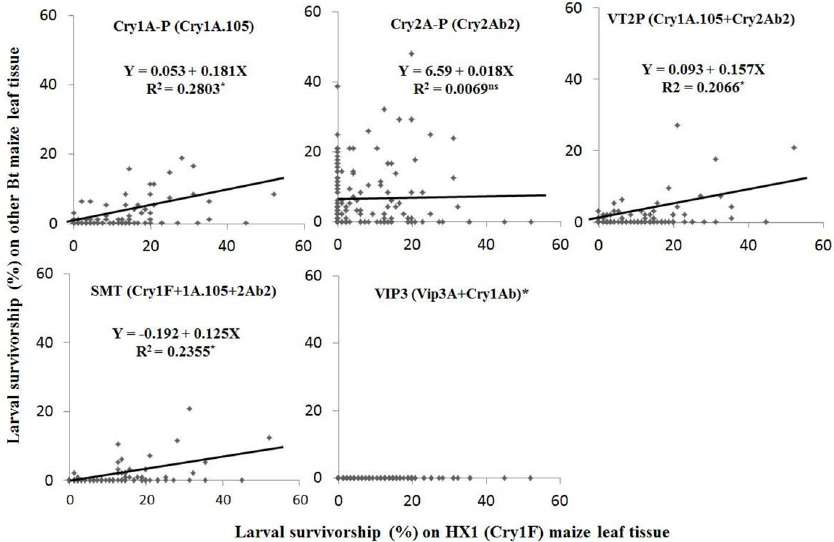
Figure 2. Correlation analysis on larval survivorship (%) of 142 F 2 two-parent families between HX1 vs. five other Bt maize products. Analysis was performed by treating survival on HX1 as the independent variable (X) and survival on the other five Bt products as the dependent variable (Y) [38]. HX1, Pioneer 31D59; Cry1A-P, an experimental line expressing the Cry1A.105 protein; Cry2A-P, an experimental line expressing the Cry2Ab2 protein; VT2P, DKC 61-49; SMT, DKC 62-08; VIP3, N78N-3111. ‘‘*’’ indicates statistical significance ( P , 0.05), while ‘‘ns’’ indicates not significant ( P $ 0.05).